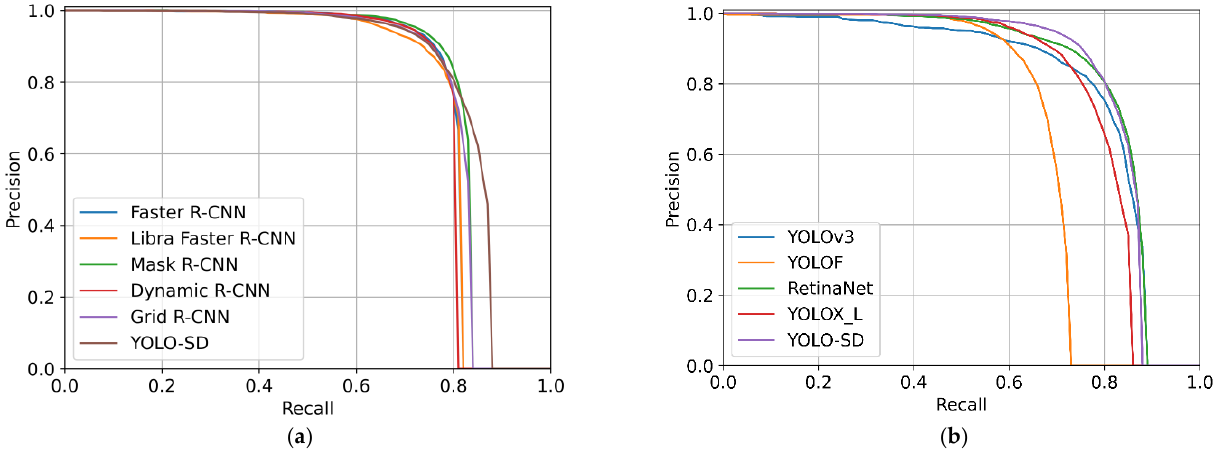
Figure 8. Comparison of Precision-Recall curves of different models. ( a ) Two-stage models. ( b ) One- stage models.